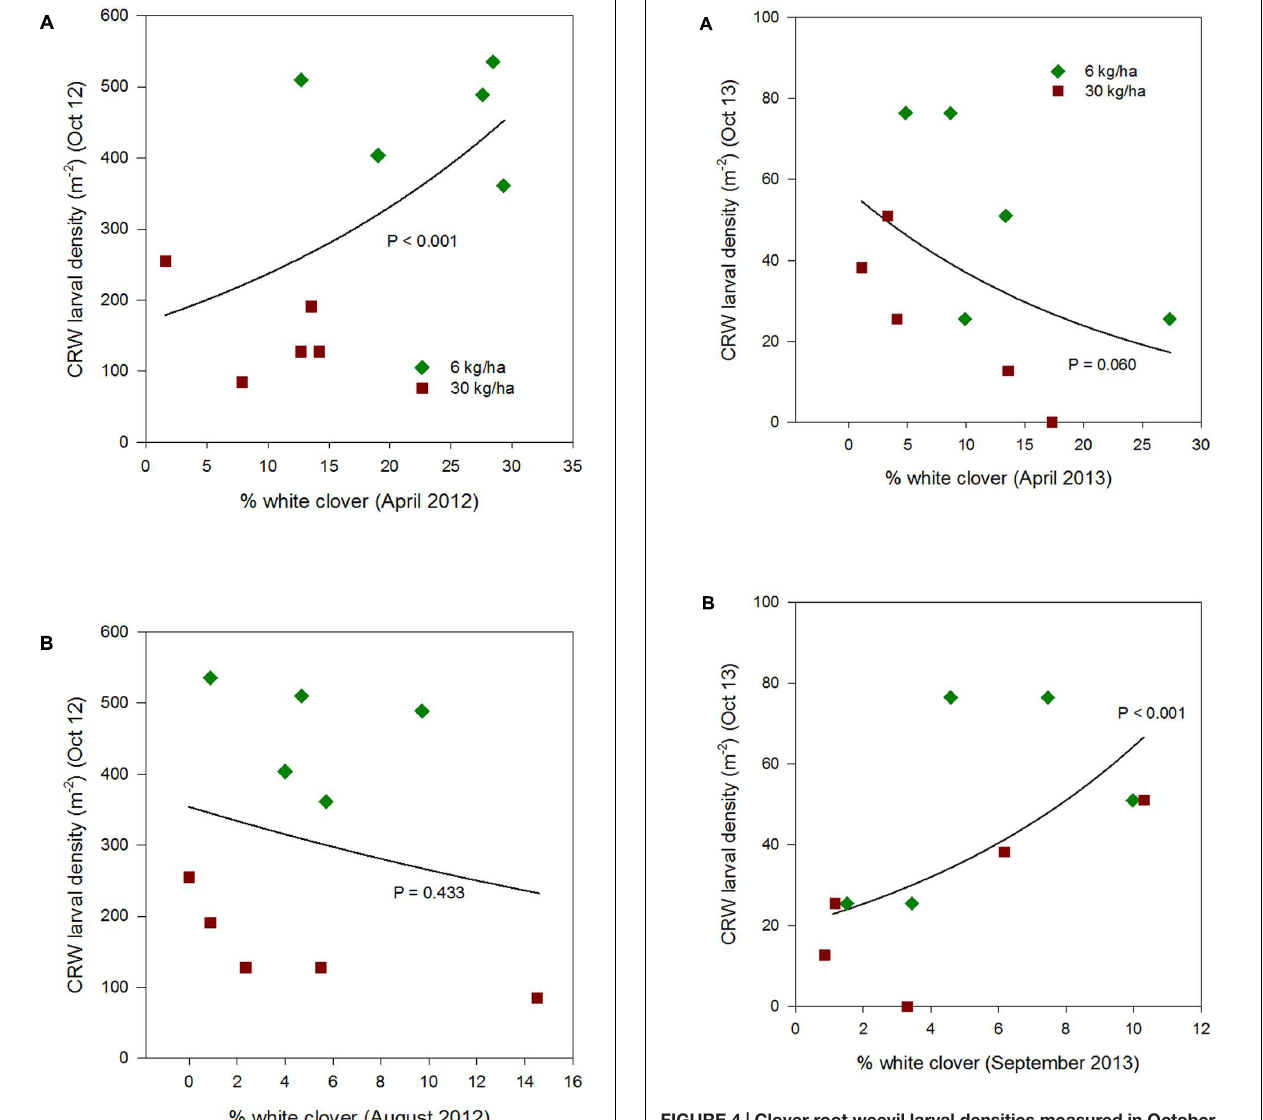
FIGURE 4 | Clover root weevil larval densities measured in October 2013 in relation to % white clover measured in April 2013 (A) and September 2013 (B), from ryegrass plots (cv. Nui) sown at 6 and 30 kg/ha (solid line shows the estimated relationship across all plots, irrespective of ryegrass sowing